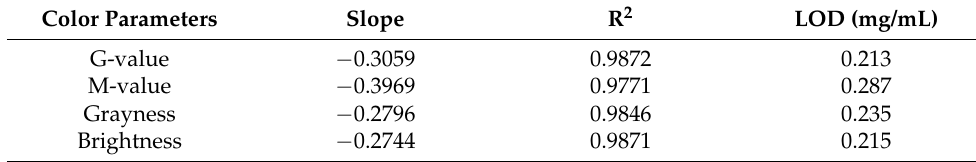
Table 2. Slope, R 2 , and detection limit obtained by fitting the four-color parameters.